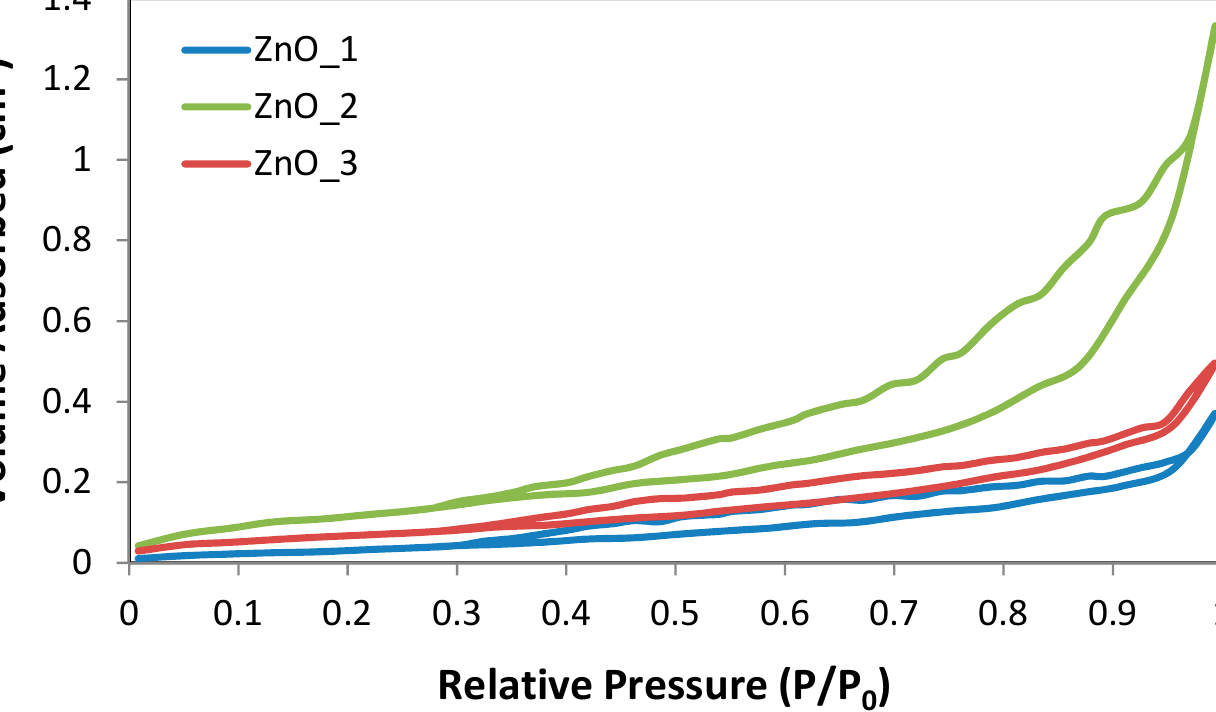
Figure 6. Nitrogen adsorption–desorption isotherms of the calcinated ZnO_1, ZnO_2 and ZnO_3 Scheme 6. reveals type IV physisorption isotherms and very small H3 hysteresis loops for all sam- ples and very low nitrogen uptake at high relative pressure. This very low physisorption in ZnO particles confirmed the crystalline nature of both samples.